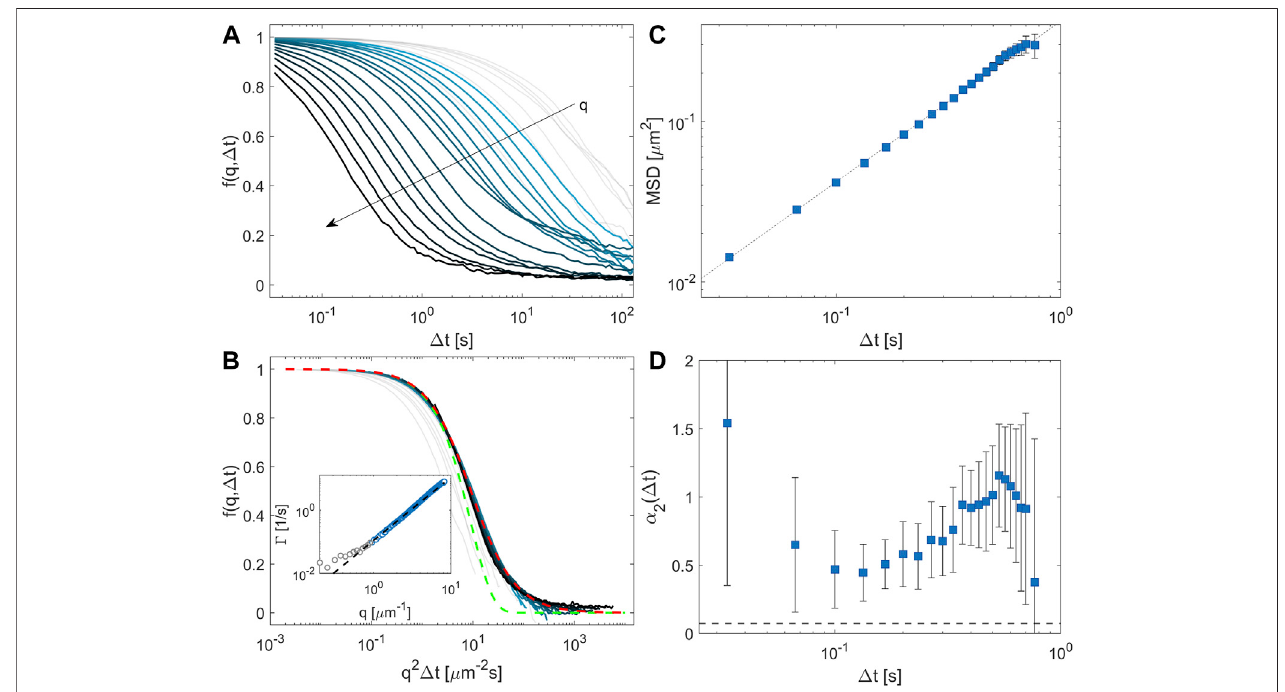
FIGURE 3 | ConDDM analysis of small particles exploring a glassy environment ( ϕ = 0.60) (A) Representative collective ISFs for different q -values: gray lines representtheISFsforwavevectors q < q c ,whereasISFsfromcyantoblackcorrespondtowavevectorsintherange[0.9 – 7.5] μ m − 1 . (B) Representativeself-ISFsforthe same q-range of panel (A) plotted as a function of the rescaled time delay q 2 Δ t . The red dashed line corresponds to the Lorentzian-like model f self (cid:2) [ 1 + D 60 , a q 2 Δ t ] − 1 , whereas the green dashed line represents a simple exponential model for the ISFs f ( q , Δ t ) (cid:2) e − D 60 , a q 2 Δ t . In the inset, Γ ( q ) obtained by fi tting to the experimental data theoneparametermodel f ( q , Δ t )=[1+ Γ ( q ) Δ t ] − 1 isshown.Theblackdashedlinecorrespondstothebest fi ttotheratewithaquadraticform Γ ( q )= D 60,a q 2 ,fromwhich D 60,a = (11 ± 1) × 10 – 2 μ m 2 /s is estimated. (C) MSD ( Δ t ) and (D) non-Gaussian parameter α 2 ( Δ t ) obtained from the ISFs in the low q limit together with the condition q > q c . The black dotted line in (C) corresponds to the best linear fi t to the MSD ( Δ t ) = 4 D 60,b Δ t , with D 60,b = (10.5 ± 0.5) × 10 – 2 μ m 2 /s. The black dashed line in (D) shows the mean value (cid:2) α 2 estimated for the diluted